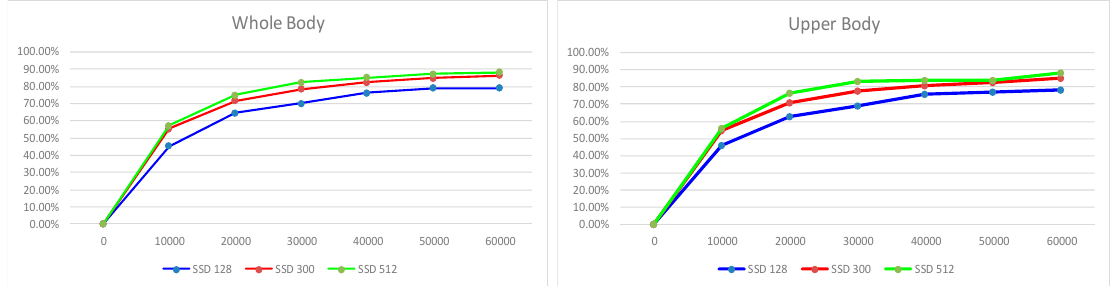
Figure 6. Training procedure of whole body and upper body, accuracy vs iterations.